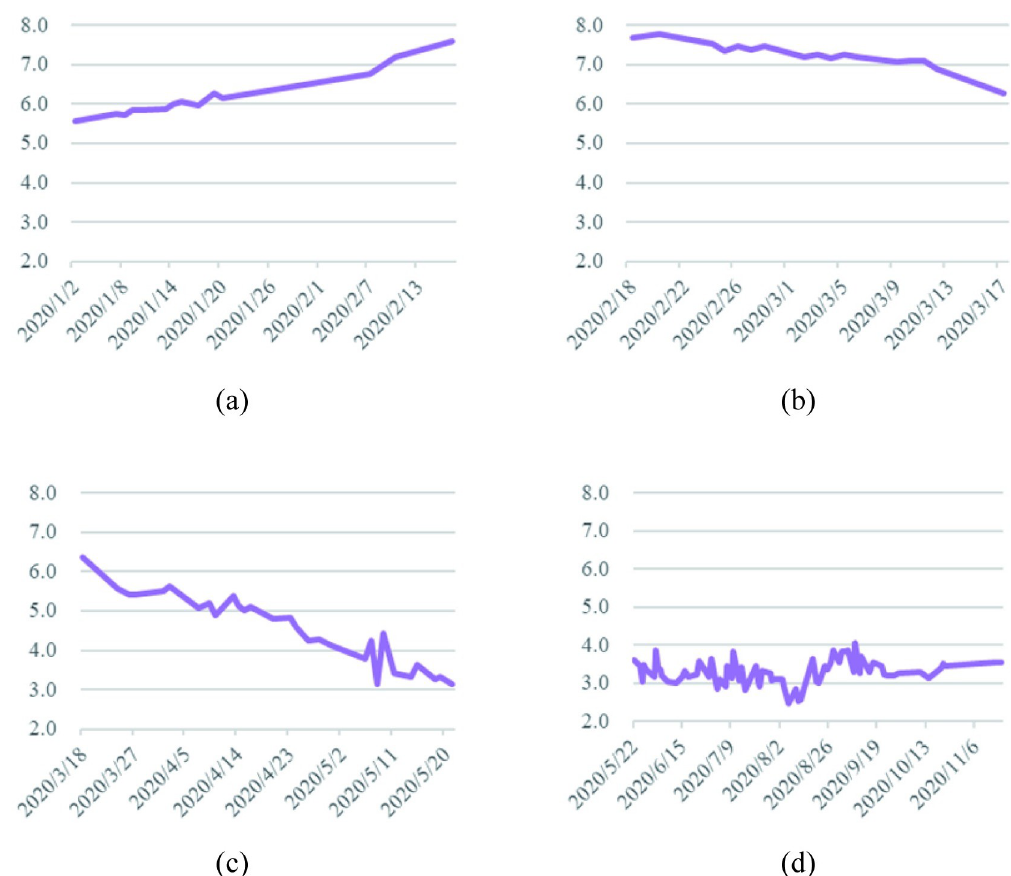
Fig 5. Eggplant prices in 2020. (a) During the outbreak phase. (b) During the epidemic mitigation phase. (c) During the epidemic interruption phase. (d) During the normalization phase of epidemic